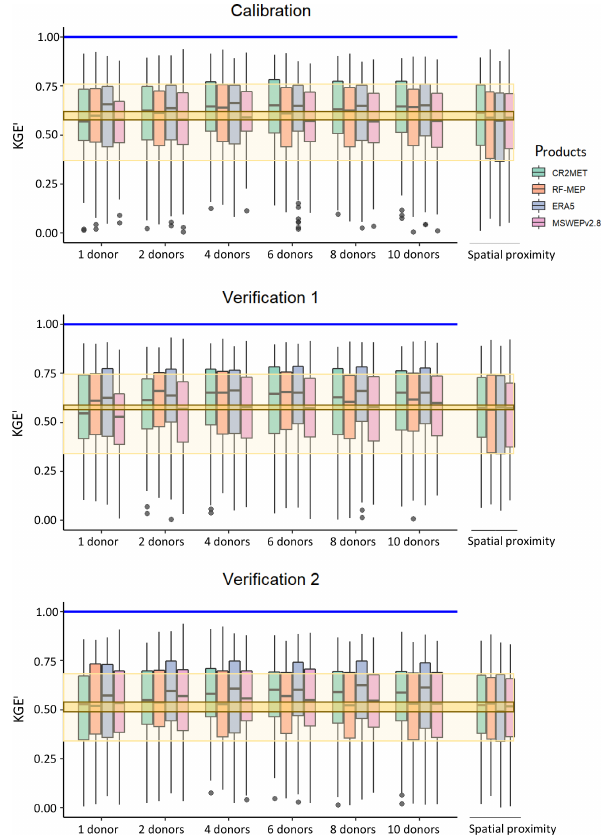
Figure 11. Influence of the number of donors used for feature simi- larity for calibration (2000–2014), Verification 1 (1990–1999), and Verification 2 (2015–2018). The results from spatial proximity are included on the right of each panel for comparison purposes. The dark yellow box denotes the upper and lower bounds of the median performance (of the four P products) obtained with spatial proxim- ity, the lighter yellow box represents the upper and lower bounds of the interquartile range for spatial proximity, and the blue lines represent the optimum KGE (cid:48)